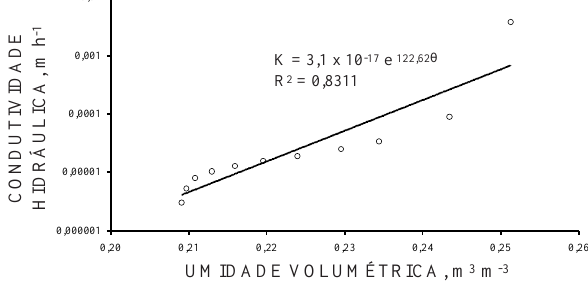
Figura 5. Condutividade hidráulica em função da umidade volumétrica (pontos), estimada com base num experimento com evaporação, para a profundidade de 0,075 m, conjuntamente com equação exponencial ajustada.